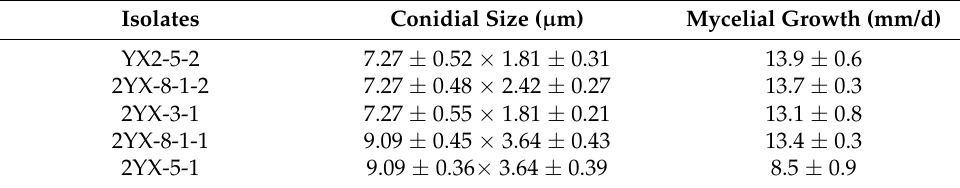
Figure 2. ( A – E ) Colony morphology of isolates YX2-5-2, 2YX-8-1-2, 2YX-3-1, 2YX-8-1-1 and 2YX-5-1 on PDA after 5 days at 28 °C, respectively; ( F – J ) Conidia of isolates YX2-5-2, 2YX-8-1-2, 2YX-3-1, 2YX-8-1-1 and 2YX-5-1, respectively; scale bar = 10 μ m. Table 1. Summary of the morphological data of the five isolates.